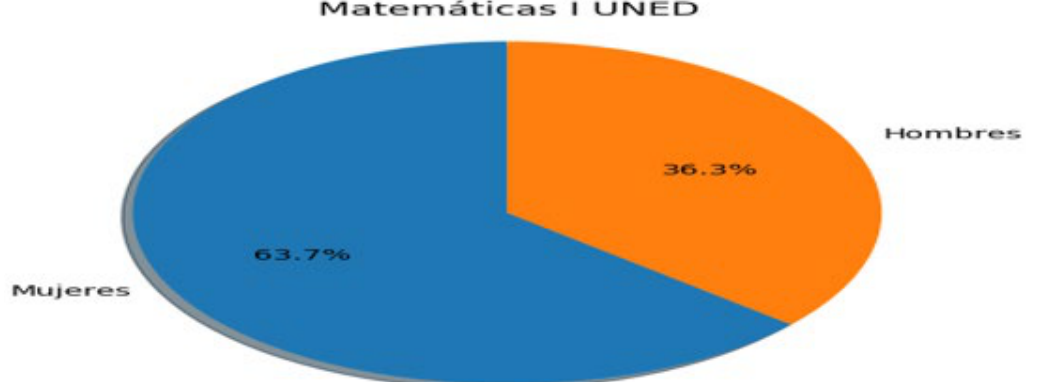
Figure 3. Female students vs. male students in one of the subject